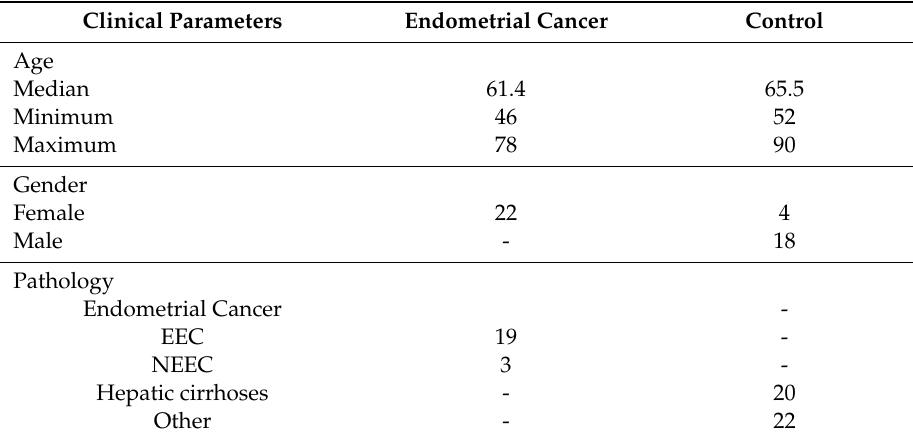
Table 1. Clinicopathological characteristics of